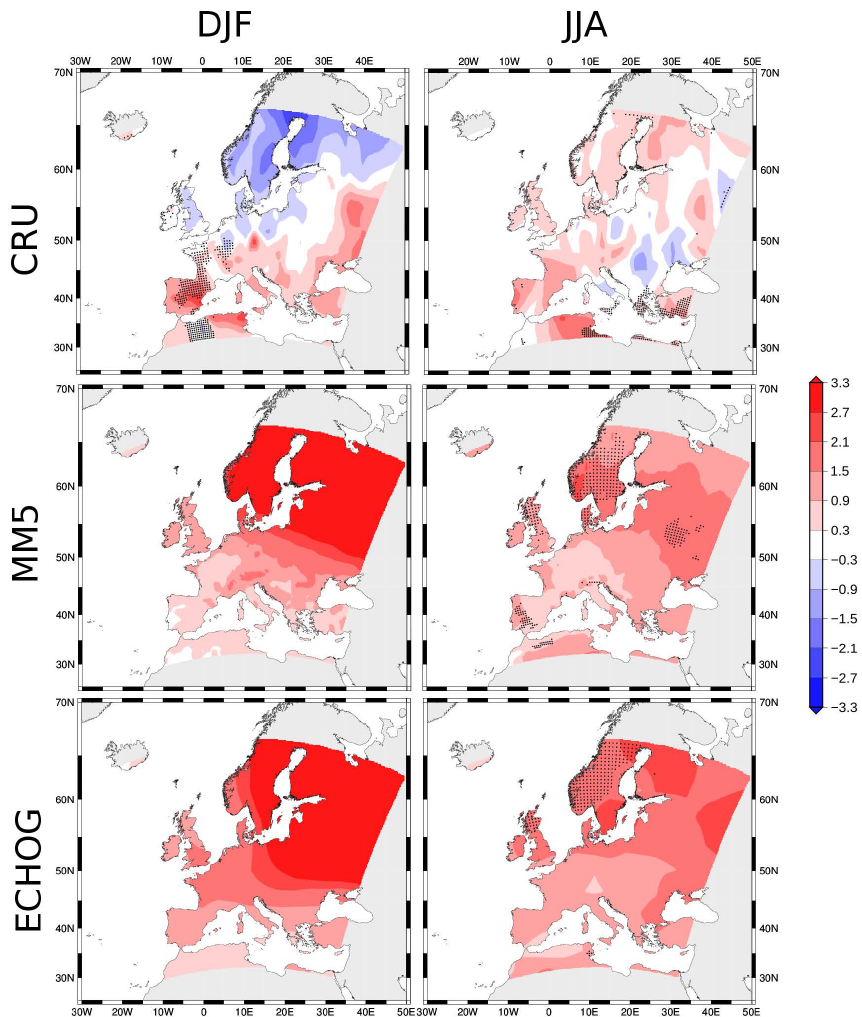
Fig. 8. Trends (in Kcentury − 1 ) in the seasonal SAT series in the 1900–1990 period for winter (left panels) and summer (right panels) in CRU (top panels) MM5 driven by ECHO-G (middle panels), and ECHO-G alone (bottom panels). To perform the calculations, all datasets are spatially interpolated onto the MM5 grid, and only non-ocean grid cells are considered. The significance of the trends is tested through the Mann–Kendall test, and it is indicated with small black circles in the